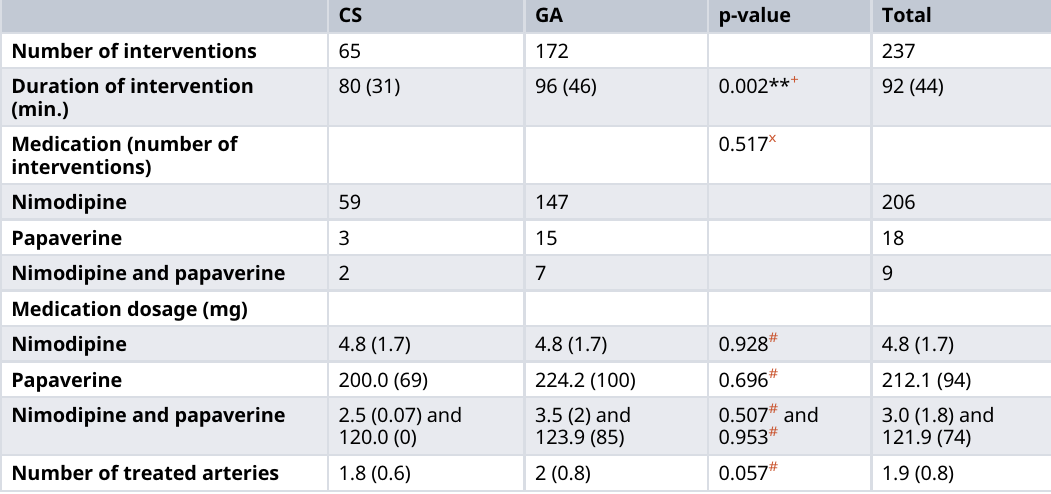
Table 3. Interventional parameters for intra-arterial vasodilator treatments. CS GA p-value Total Number of interventions 65 172 237 Duration of intervention 80 (31) 96 (46) 0.002** (min.)